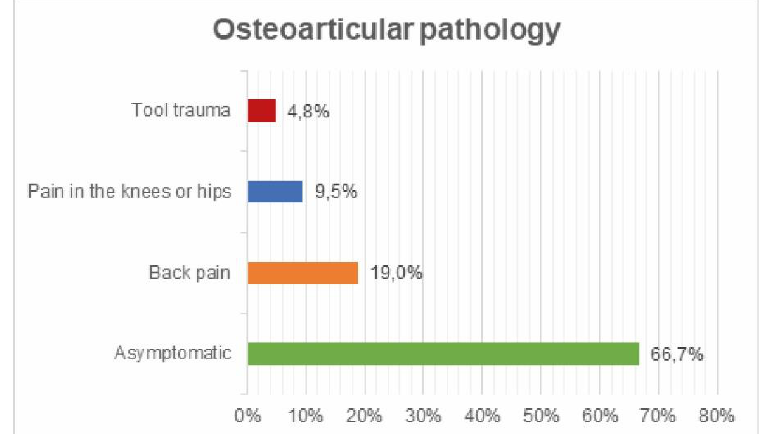
Figure 13. Osteoarticular pathology survey.